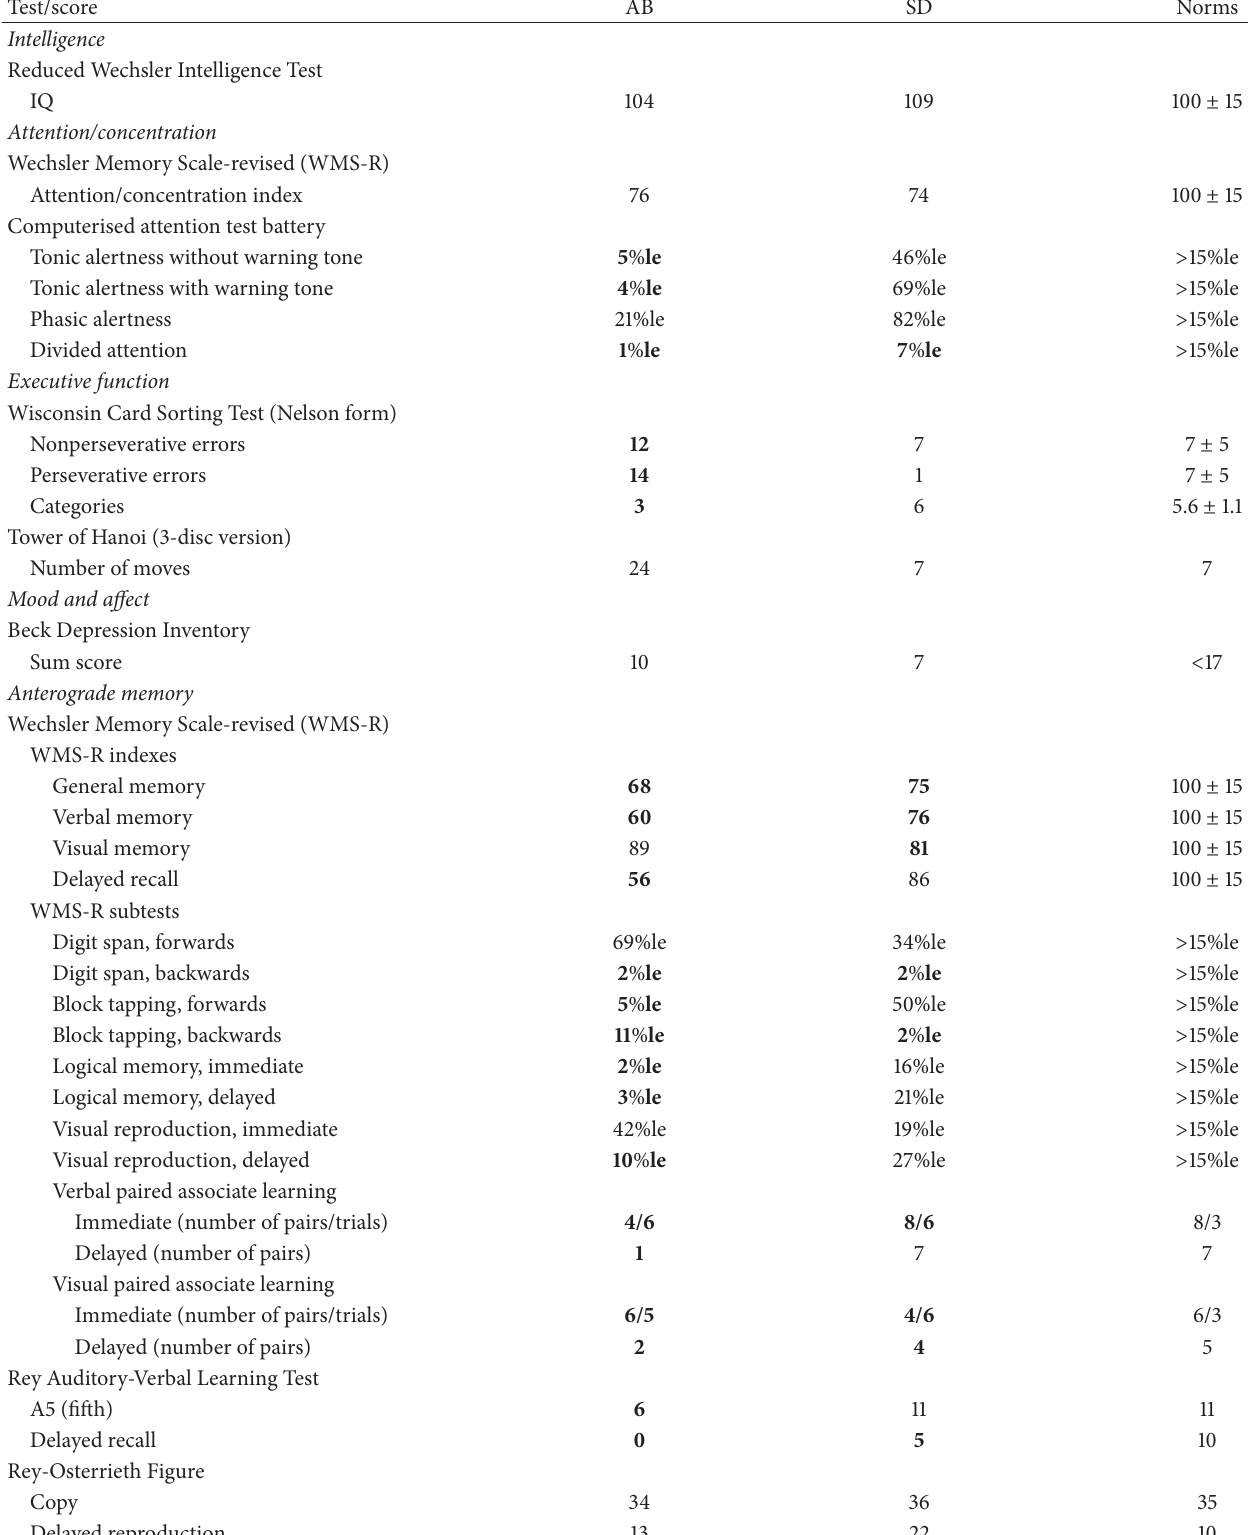
Table 1: Comparison of AB and SD performances for neuropsychological tests. Normative data are indicated as mean and standard deviation, raw scores, or percentiles. Insufficient values are indicated in bold